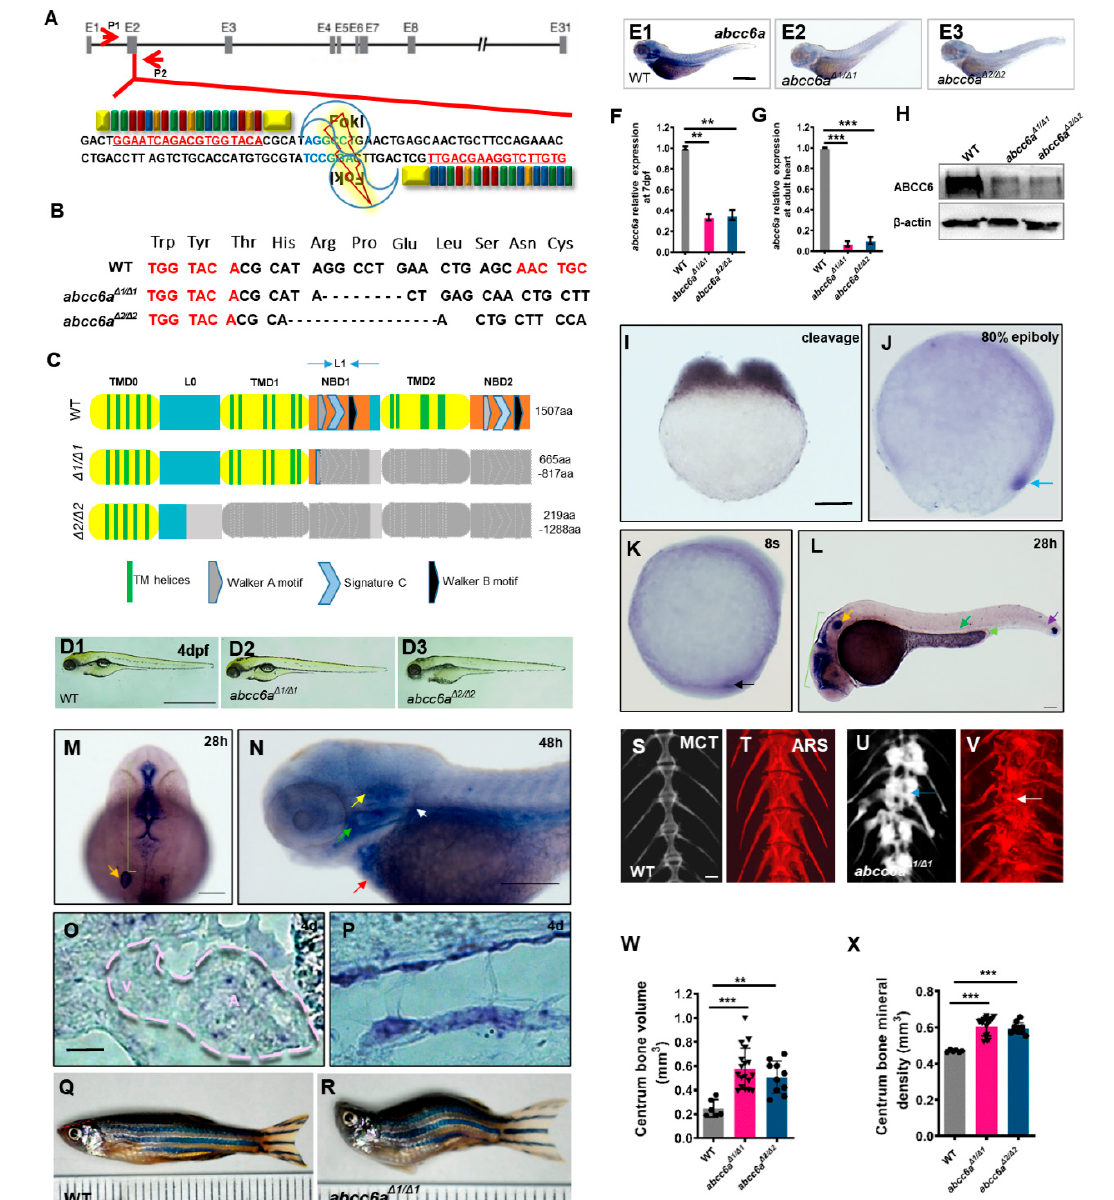
Figure 1. Generation of abcc6a mutants and expression patterns in zebrafish. ( A ) Schematic of the zebrafish abcc6a gene. Left and right arms of TALEN targeting exon 2 are color-coded to represent 4 repeat-variable diresidues (RVDs) (red, NI = A; green, NN = G; blue, NG = T; orange, HD = C). Nucleotides in red letters and underlined indicate TALEN target sequence. Selected StuI site in the spacer is highlighted with violet. Genomic loci including StuI site is targeted using primer pairs P1 and P2. ( B ) Deletion mutations generated by TALEN at the abcc6a gene. The WT sequence is shown at the top. Deletions are indicated by the black dashes. Red letters represent partial TALEN target sequences. Sequences are organized as sets of three bases of in-frame codons. ( C ) Domain structure and predicted amino acid sequence of WT and TALEN mutants. Gray shade indicates regions missing in the mutant proteins. All mutants contain premature stop codon resulting in a lack of most of Abcc6a domains. ( D1 – D3 ) Lateral views showing embryo morphology of abcc6a Δ 1/ Δ 1 ( D2 ) and abcc6a Δ 2/ Δ 2 mutants ( D3 ) and WT siblings ( D1 ) at 4 dpf. ( E1 – E3 ) Whole-mount in situ hybridization (WISH) analysis of abcc6a expression at 4 dpf in abcc6a Δ 1/ Δ 1 ( E2 ) and abcc6a Δ 2/ Δ 2 mutants ( E3 ) and wild-type siblings ( E1 ). ( F , G ) abcc6a expression levels were examined using real-time PCR analysis in abcc6a Δ 1/ Δ 1 and abcc6a Δ 2/ Δ 2 mutant larvae at7 dpf ( F ) and adult hearts ( G ). Expression levels were normalized to the expression of β -actin . Data are mean ± SEM from 20 larvae and 6 hearts for each group. ** p < 0.01, *** p < 0.001, Student’s t -test (unpaired, two-tailed). ( H ) Western blot analysis showing ABCC6 protein levels in abcc6a Δ 1/ Δ 1 and abcc6a Δ 2/ Δ 2 mutants and WT larvae at 7 dpf. ( I – K ) WISH showing ubiquitous abcc6a expres- sion at the two-cell stage ( I ), the 80%-epiboly stage ( J ), and 8 somite stages ( K ). Blue arrow indicates dorsal forerunner